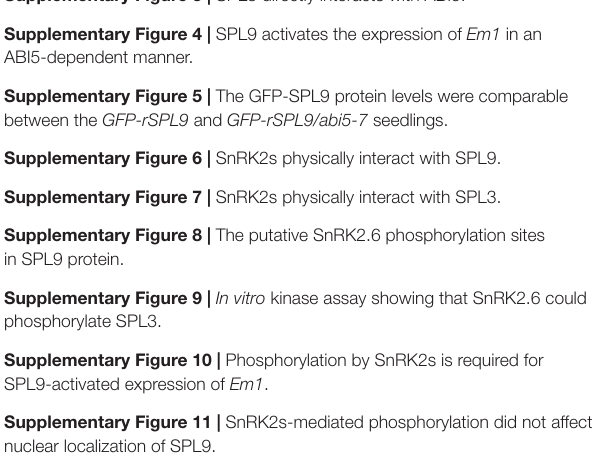
Supplementary Figure 1 | The miR156-targeted SPLs positively regulate ABA responses during seed germination and cotyledon greening. Supplementary Figure 2 | SPL9 directly activates the transcriptional expression of Em1 . Supplementary Figure 3 | SPL3 directly interacts with ABI5. Supplementary Figure 4 | SPL9 activates the expression of Em1 in an ABI5-dependent manner. Supplementary Figure 5 | The GFP-SPL9 protein levels were comparable between the GFP-rSPL9 and GFP-rSPL9/abi5-7 seedlings. Supplementary Figure 6 | SnRK2s physically interact with SPL9. Supplementary Figure 7 | SnRK2s physically interact with SPL3. Supplementary Figure 8 | The putative SnRK2.6 phosphorylation sites in SPL9 protein. Supplementary Figure 9 | In vitro kinase assay showing that SnRK2.6 could phosphorylate SPL3. Supplementary Figure 10 | Phosphorylation by SnRK2s is required for SPL9-activated expression of Em1 . Supplementary Figure 11 | SnRK2s-mediated phosphorylation did not affect the nuclear localization of